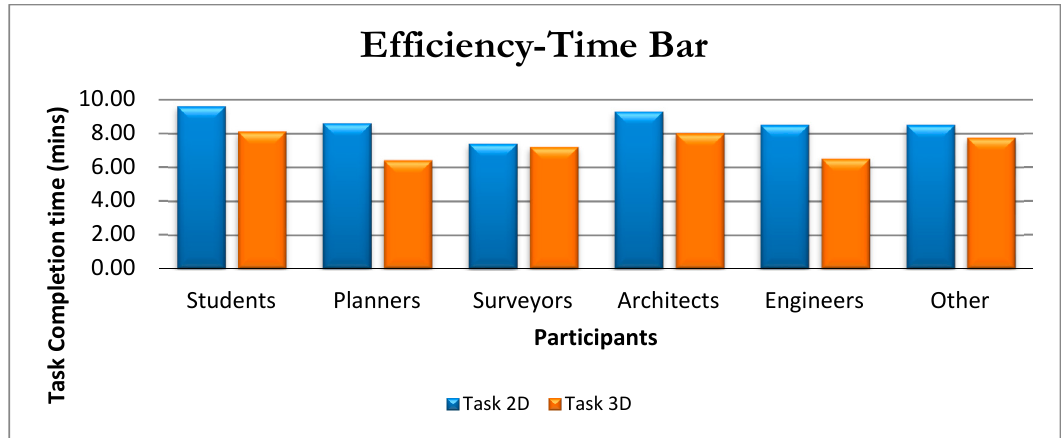
Figure 5. Task completion time per participant group (efficiency).